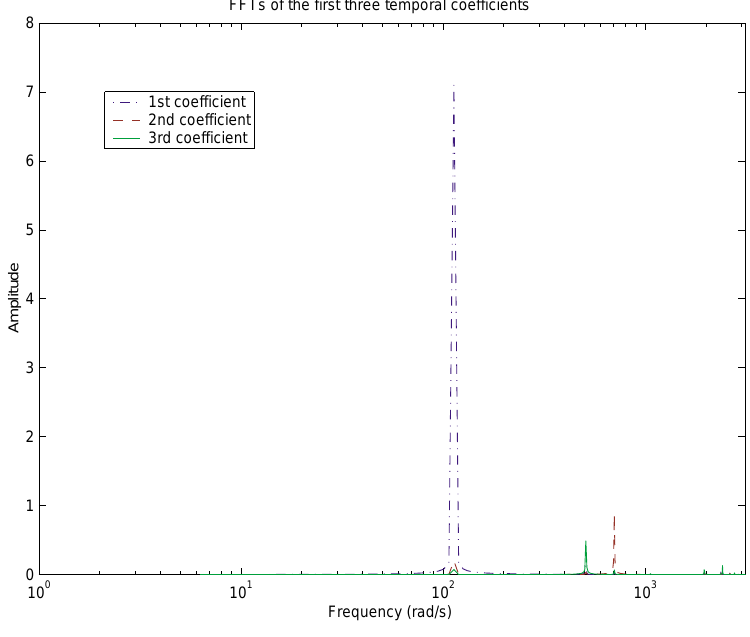
Fig. 10. FFT of temporal coefficients relative to the first three POMs presented in Fig.